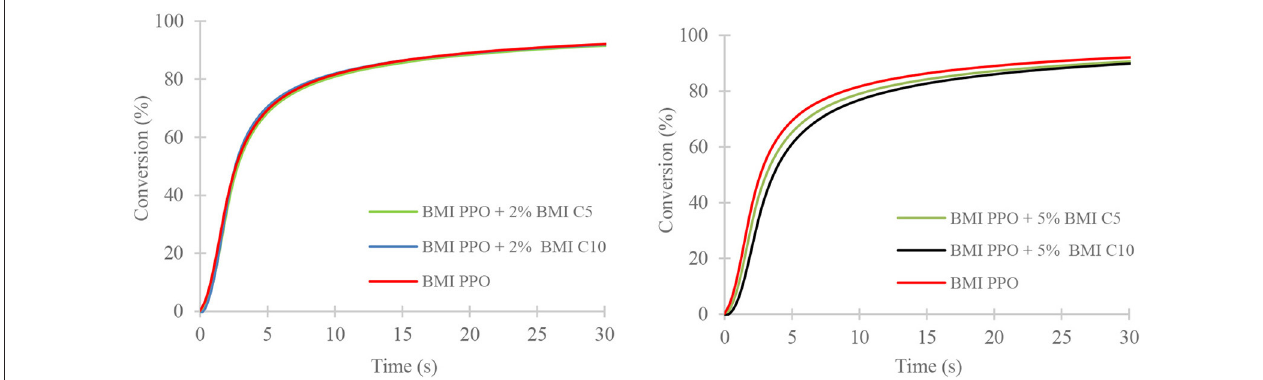
FIGURE 4 | Effect of the amount of BMI C5 and BMI C10 on the photopolymerization conversion curves in absence of air.